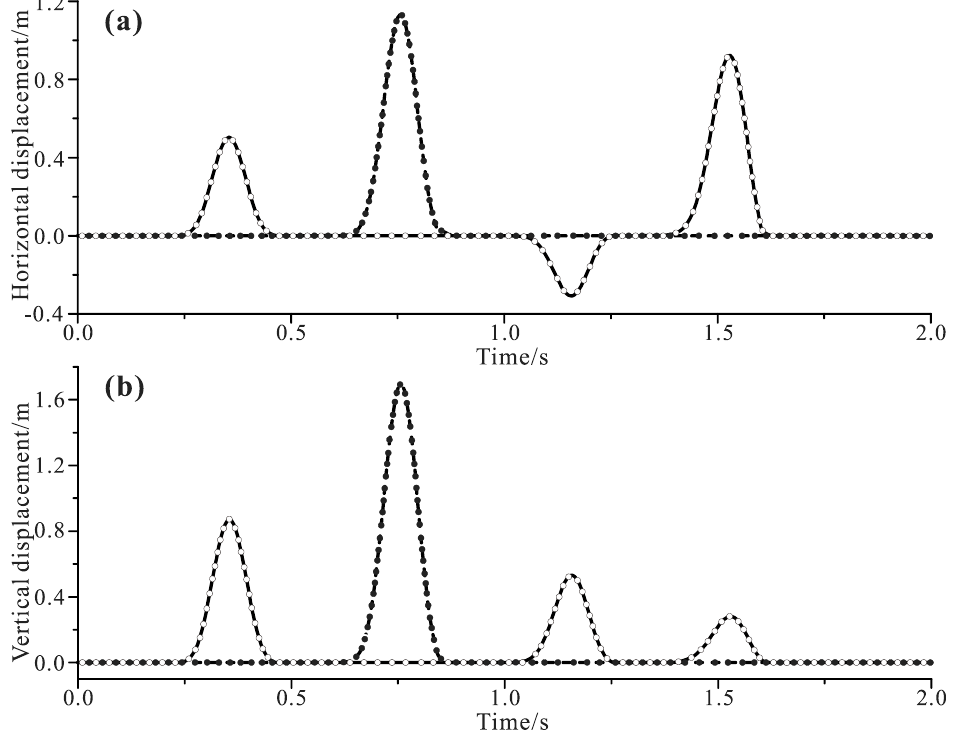
Figure 10. Displacement time history at observation points of incident P waves: ( a ) horizontal displacement, and ( b ) vertical displacement (solid lines and dashed lines are numerical results of points A and B, respectively, with circles showing analytical solutions).